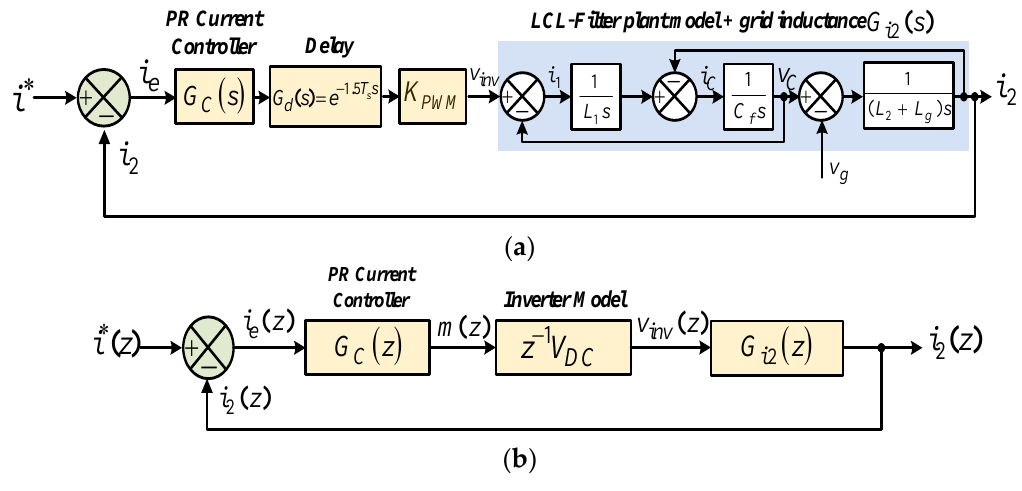
Figure 4. Block diagram of single-loop grid-side current control scheme without any damping method: ( a ) s -domain; and ( b ) z -domain.